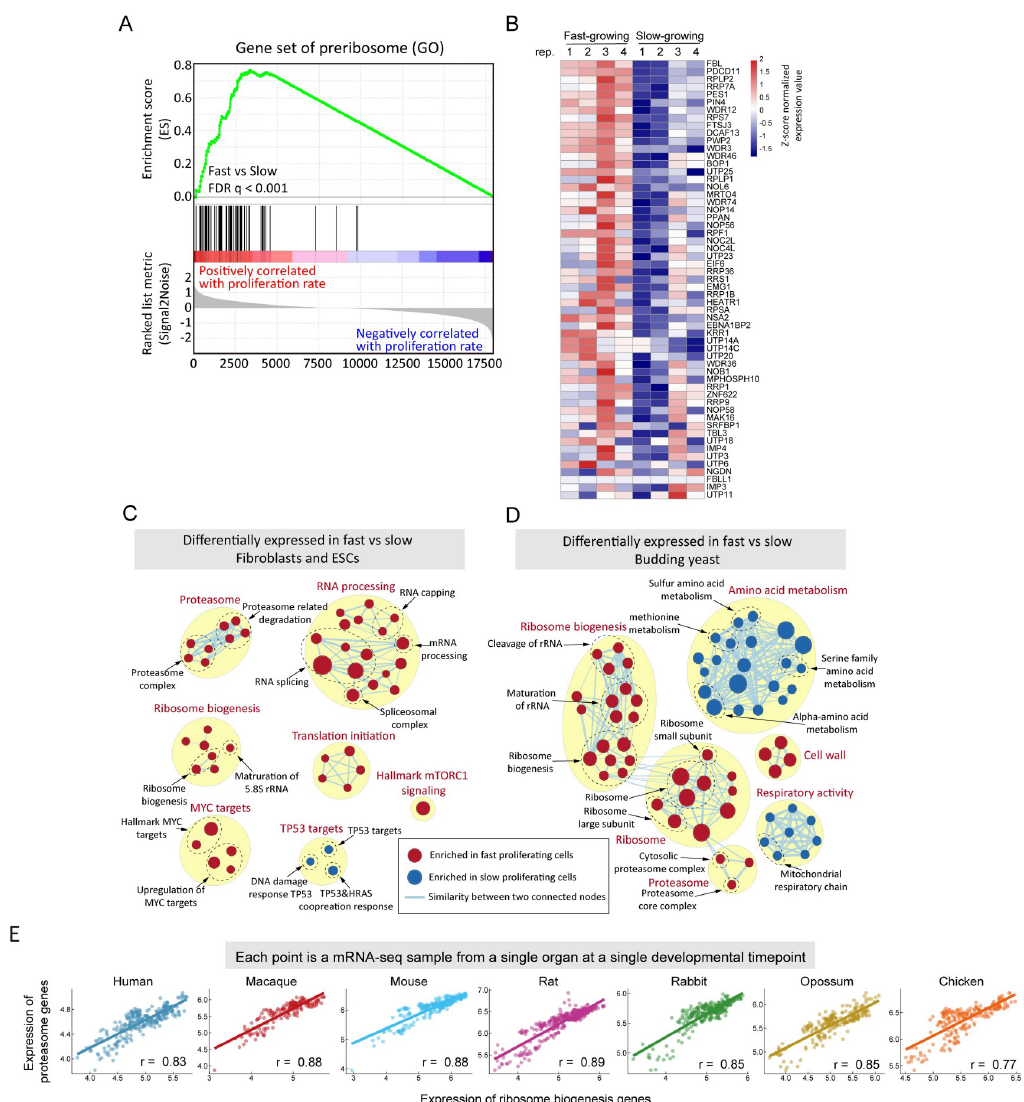
Fig 3. Functional pathways for which cell-to-cell heterogeneity in expression correlates with proliferation rate across cell types and species. (A) In Gene Set Enrichment Analysis, genes are sorted by their fast/slow expression value (left panel, bottom), and each gene is represented by a single black line (left panel middle). The enrichment score is calculated as follows: for each gene not in the GO preribosome gene set, the value of the green line decreases, and for each gene in the gene set, the value of the green line increases. The ES score will be near zero if the genes in a gene set are randomly distributed across the sorted list of genes, positive if most genes are to the left, and negative if most genes are to the right. (B) The heatmap (right panel) shows the expression (z-scored read counts) of preribosome genes in fibroblasts across four biological replicates of the CFSE sorting experiment. (C) Gene sets enriched (FDR < 0.1) in both fibroblasts and ESCs were mapped as a network of gene sets (nodes) related by mutual overlap (edges), where the color (red or blue) indicates if the gene set is more highly expressed in fast (red) or slow (blue) proliferating cells. Node size is proportional to the total number of genes in each set and edge thickness represents the number of overlapping genes between sets. (D) GSEA results (FDR < 0.1) of S . cerevisiae [8] that sorted by cell-to- cell heterogeneity in proliferation rate. (E) Pearson correlations of mean expression (average of log2(TPM+1)) of ribosome biogenesis genes vs proteasome genes across organ developmental time courses in seven species (see also S2 Fig ).